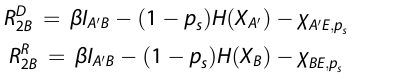
ffiffiffiffiffiffiffiffiffiffiffiffiffiffi p k max X A and has a